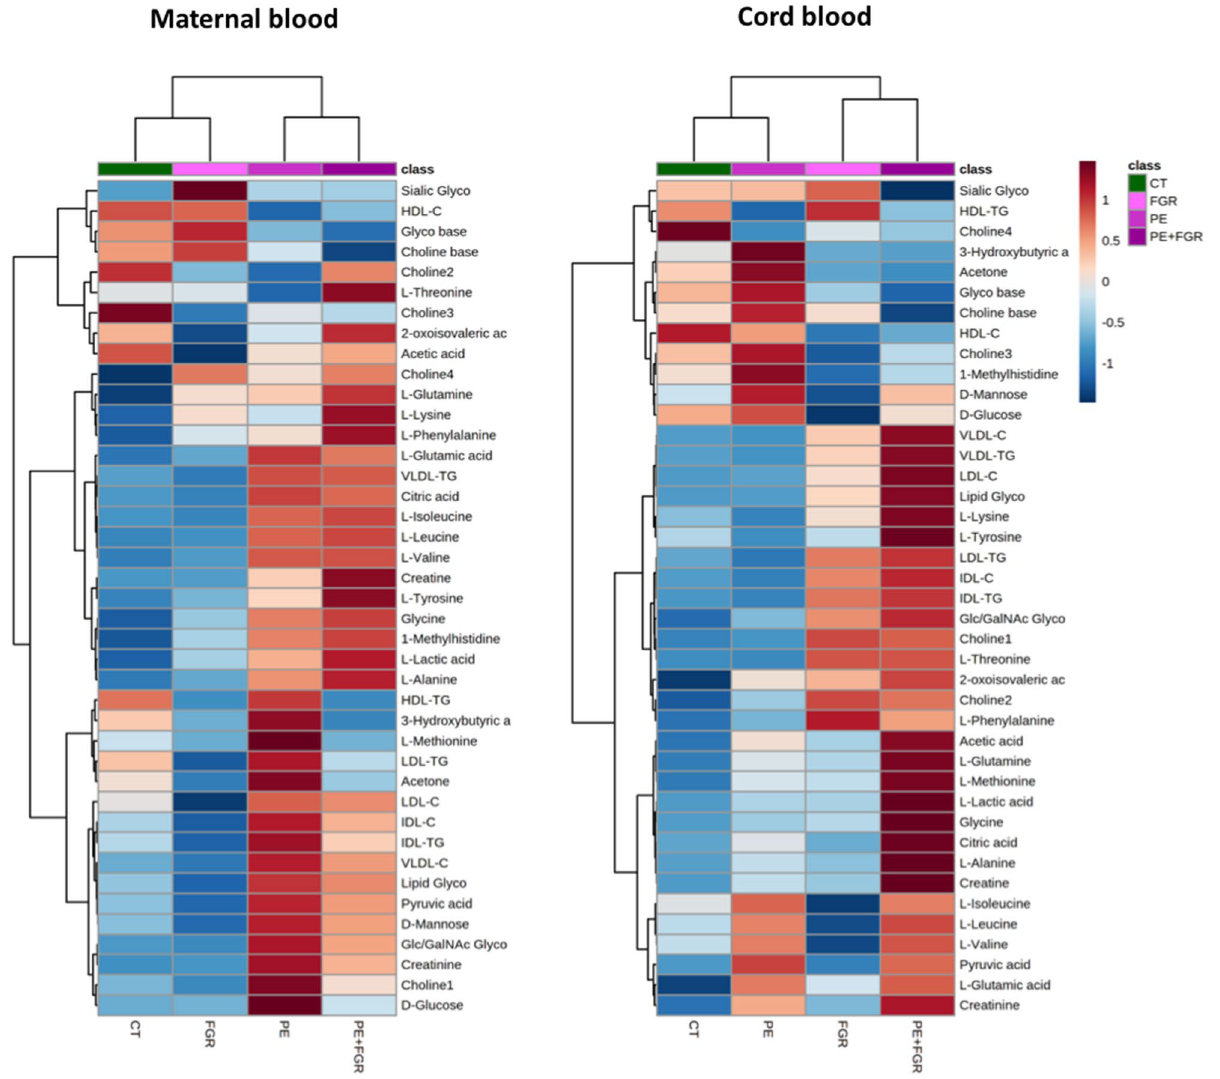
Figure 1. Metabolomic heat maps. Left-side, maternal (controls [n = 88], FGR [n = 44], PE [n = 40], PE + FGR [n = 50]); right-side, cord blood (controls [n = 86], FGR [n = 43], PE [n = 37], PE + FGR [n = 50]) plasma samples. A z-score transformation was performed on the intensity of each metabolite across all the study groups and each group’s mean z-score is displayed in the heatmap. Rows represent metabolites and columns represent samples. Samples and metabolites are clustered by Euclidean distance and Ward linkage. CT, controls; FGR, fetal growth restriction; PE, preeclampsia; VLDL, Very low-density lipoprotein; IDL, Intermediate-density lipoprotein; LDL, Low-density lipoprotein; HDL, High-density lipoprotein; C, cholesterol; TG, triglycerides; Glc/GalNAc, N-acetylglucosamine and N-acetylgalactosamine bonds